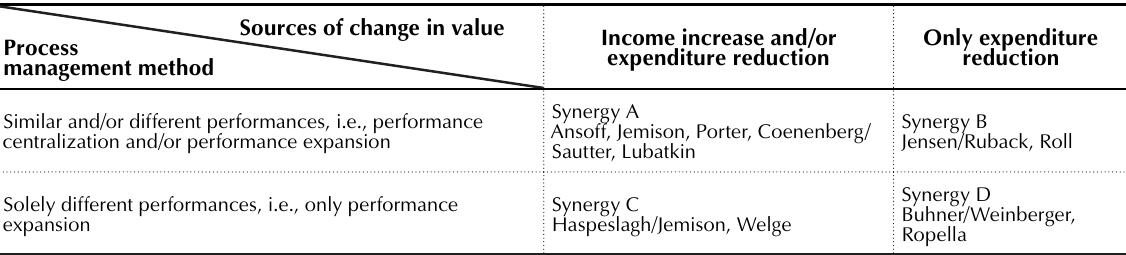
Table 1. Sources of change in value and method of performance processes to differentiate the term